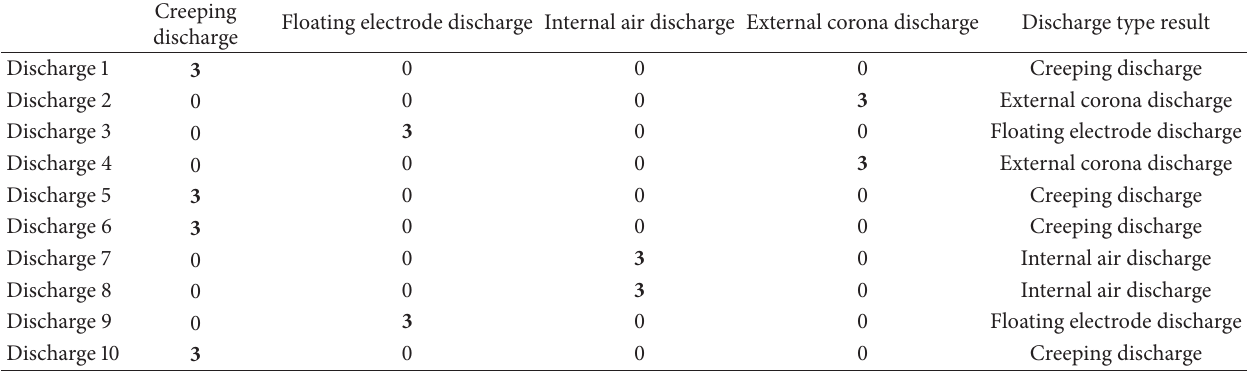
Table 7: Vote results of testing samples.